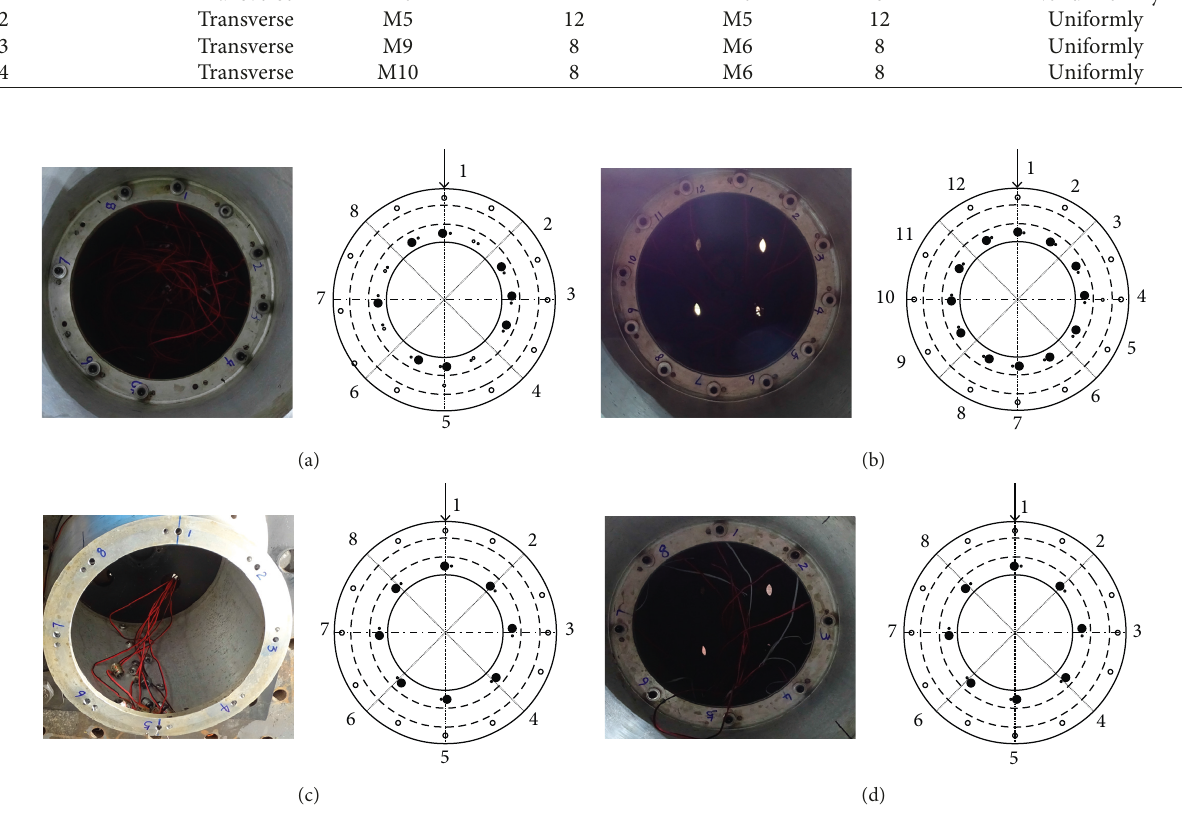
Figure 3: The distribution conditions and identifiers of the bolts. (a) T-1, (b) T-2, (c) T-3, and (d) T-4.